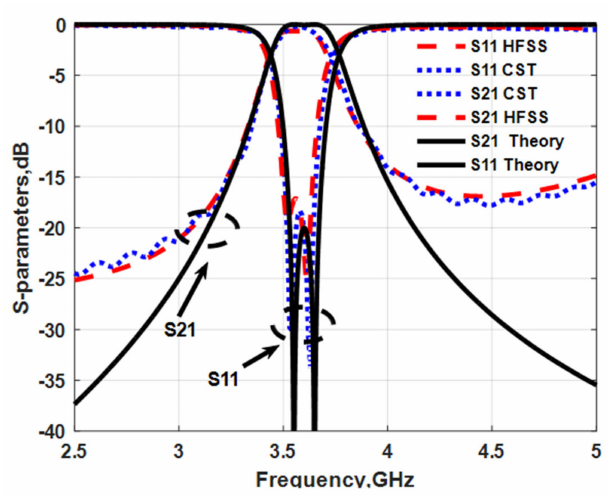
Figure 6. S 11 , S 21 simulated results of the second-order